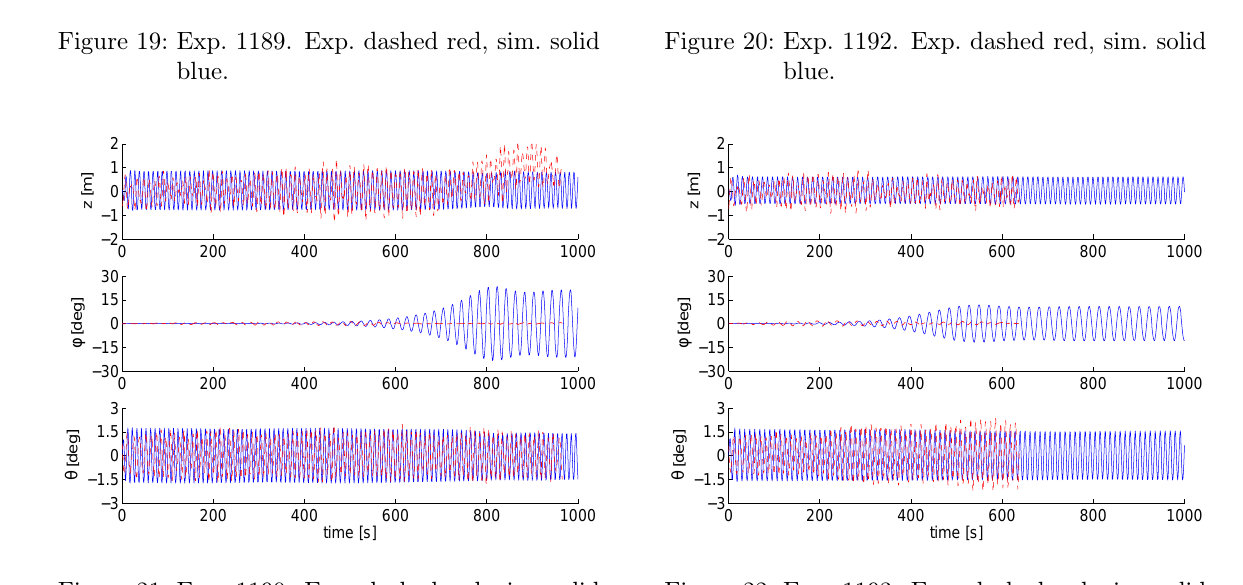
Figure 21: Exp. 1190. Exp. dashed red, sim. solid blue.